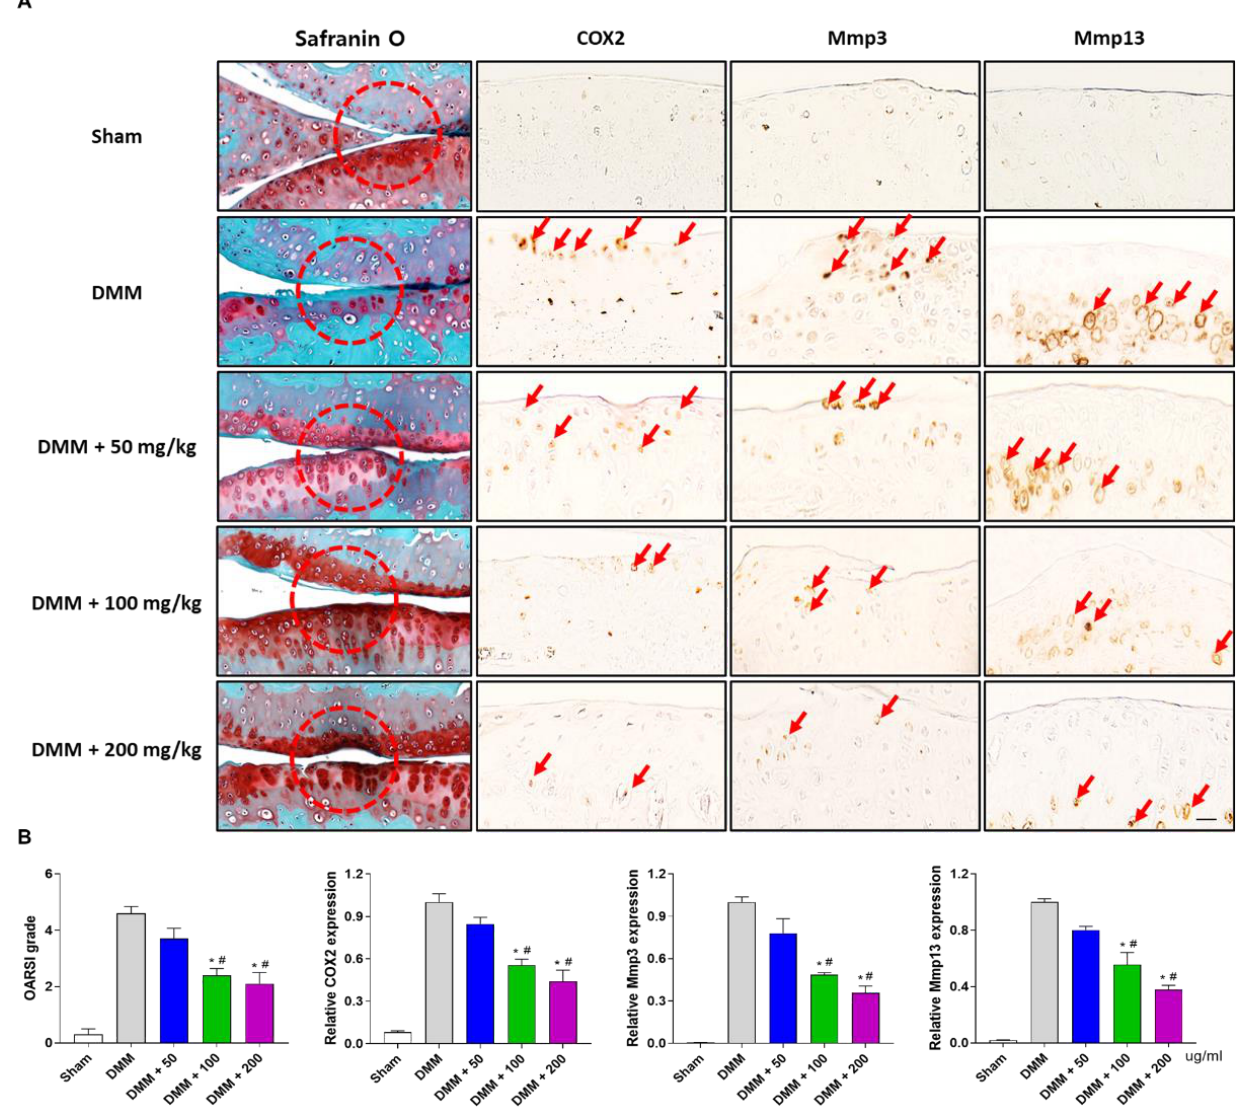
Figure 6. Effects of PG extract on catabolic factors in a DMM-induced OA mouse model. ( A ) Representative images for safranin O staining and immunohistochemistry (IHC) for COX2, Mmp3 and Mmp13 of articular cartilage. ( B ) OARSI scoring and quantification of IHC for COX2, Mmp3 and Mmp13 was determined. * p < 0.05 vs. DMM, # p < 0.05 vs. DMM + 50. Sham; non-treated group.